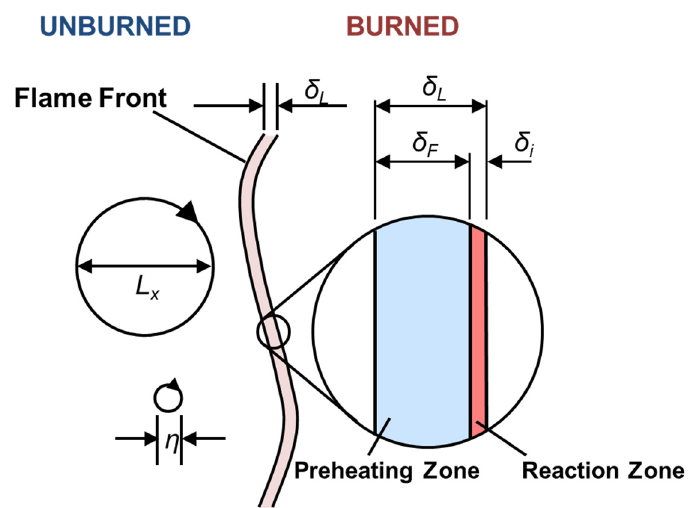
Figure 5. Length scales in turbulent combustion acc. to Peters.